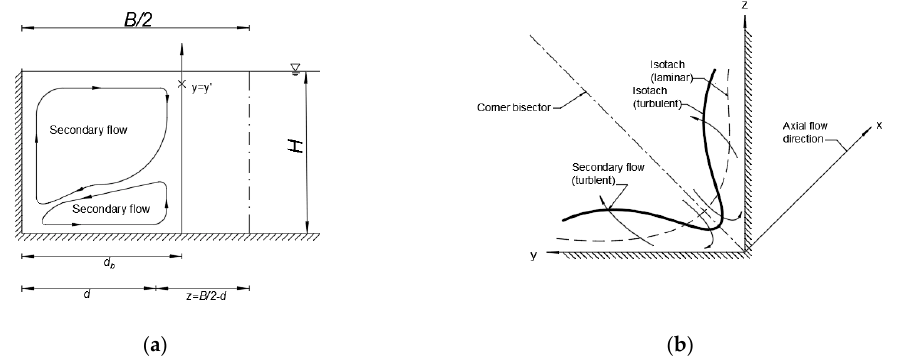
Figure 1. Secondary flow in the cross section: ( a ) Secondary currents around the corner region [2]; ( b ) Typical isotach patterns for flow along a corner [9].